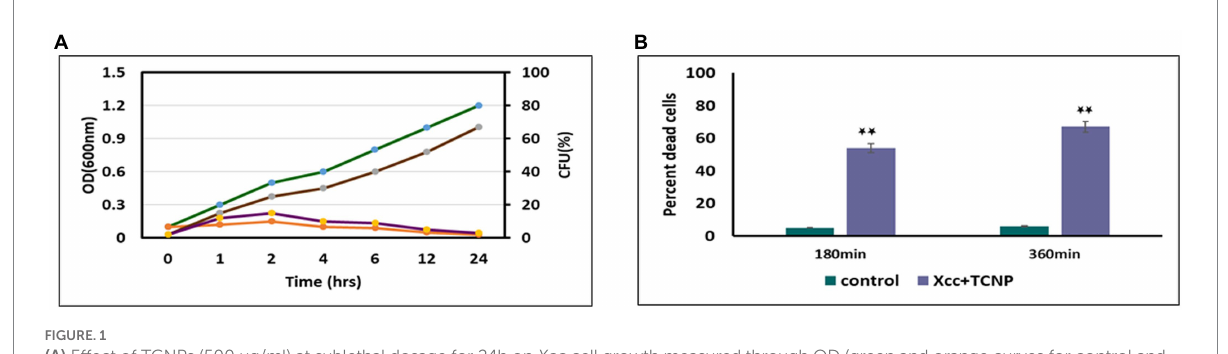
FIGURE. 1 (A) Effect of TCNPs (500 ug/ml) at sublethal dosage for 24 h on Xcc cell growth measured through OD (green and orange curves for control and TCNP treated Xcc cells) and CFU (brown and violet for control and TCNP treated Xcc cells); (B) percent dead cells when exposted to TCNP nanoparticles by tryphan blue staining. Data are represented as mean ±. S.D. of three independent experiments, each performed in triplicates and considered statistically significant when * p < 0.05.